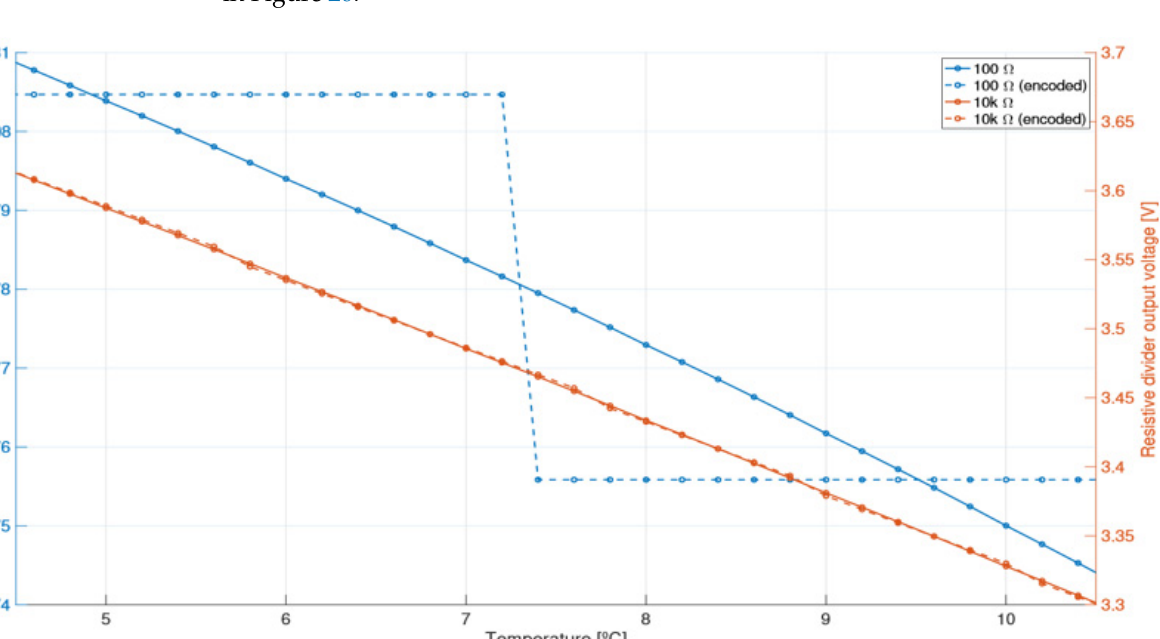
Figure 25. Resistive divider output voltage for the lowest and intermediate series resistor’s values, compared with the same encoded values for a 10 bit ADC, across the operational temperature range.